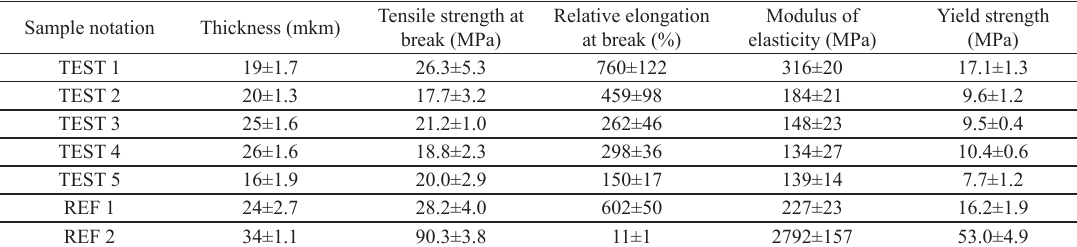
Table 3. The mechanical characteristics under tension for the bags’ samples.